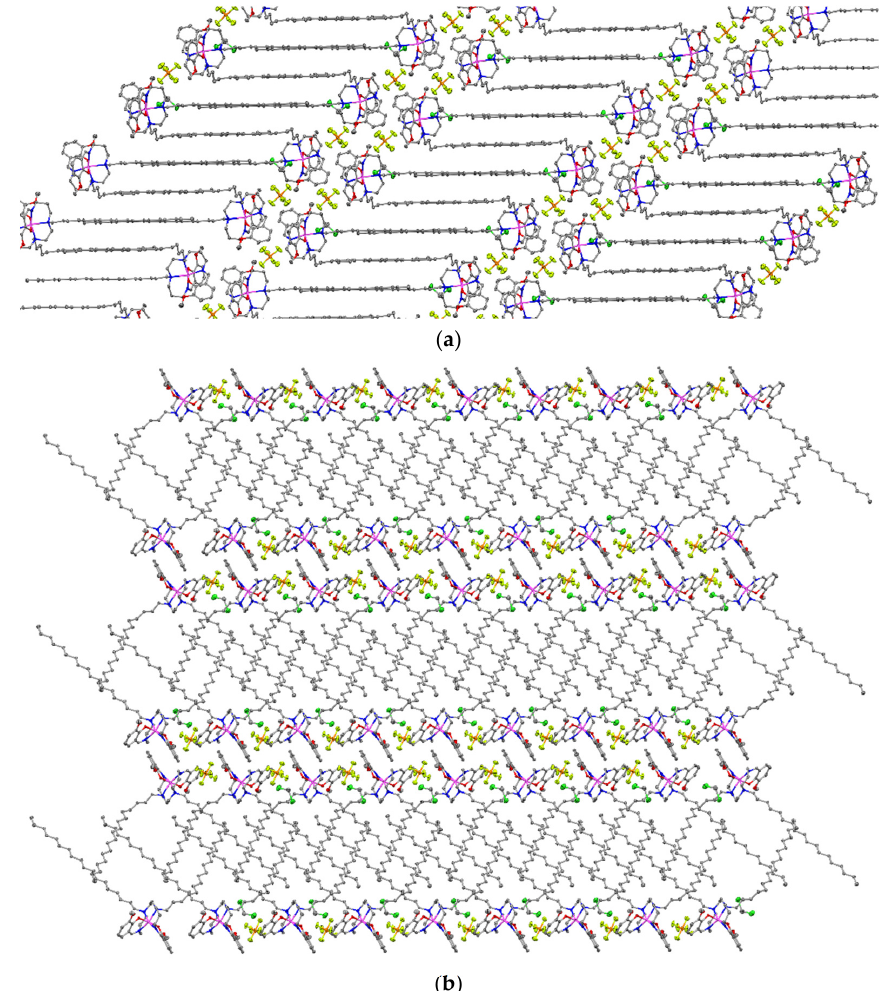
Figure 8. Long-range order present in the structures of the P-1 complex ( 12 ), [Mn(3-OMe-sal 2 323- C 18 )]PF 6 ·CH 2 Cl 2 viewed down the a-axis ( a ) and the b-axis ( b ). Data collected at 100 K and hydrogen atoms and solvent molecules were omitted for clarity.